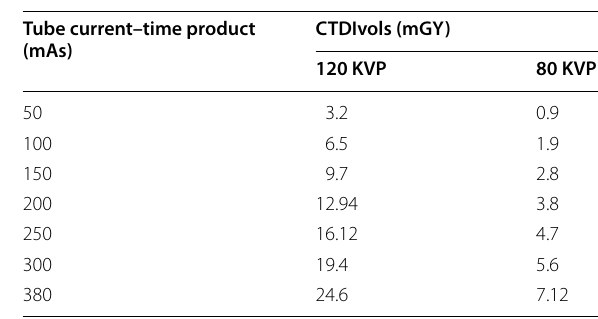
Table 1 The CTDI values obtained at 120 KVP and 80 KVP for vols each set of acquisition conditions